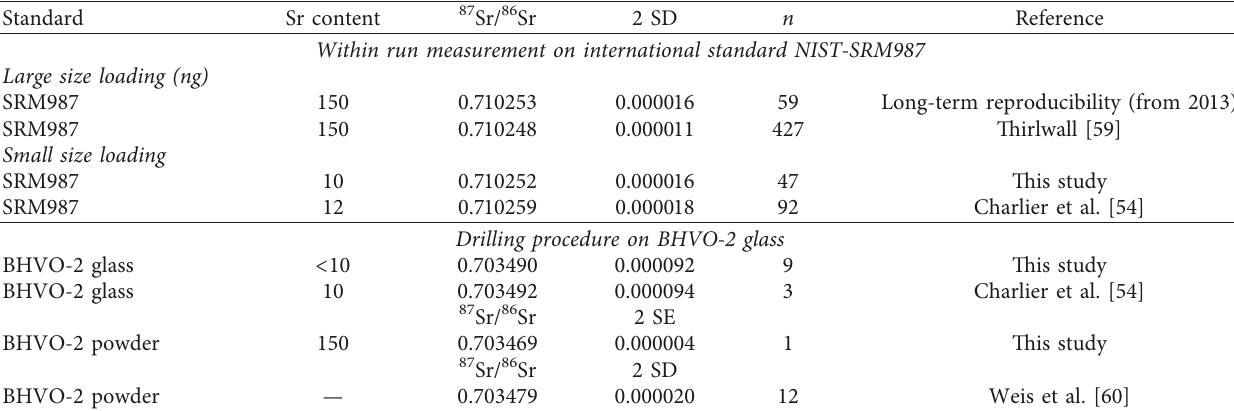
Table 3: Accuracy and reproducibility on reference standard material (NIST-SRM987 and BHVO-2).